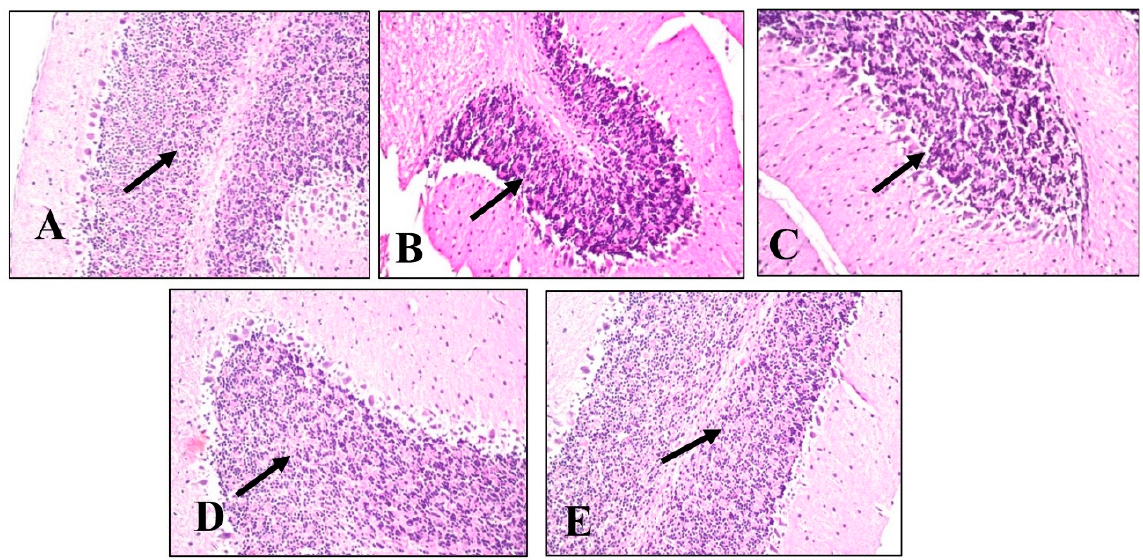
Figure 10. Histopathology of mice brain (Cerebellum sections) with H&E × 40. ( A ) Normal control group showing normal histological findings (Black arrow-normal neuron). ( B ) LPS-administered mice group showing normal histological findings (Black arrow-normal neuron). ( C ) BME-administered mice group showing normal histological findings (Black arrow-normal neuron). ( D ) BDMF-administered mice group showing normal histological findings (Black arrow-normal neuron). ( E ) BBF-administered mice group showing normal histological findings (Black arrow-normal neuron). BME: B. armeniaca methanolic extract; BDMF: B. armeniaca dichloromethane fraction; BBF: B. armeniaca butanol fraction; LPS: